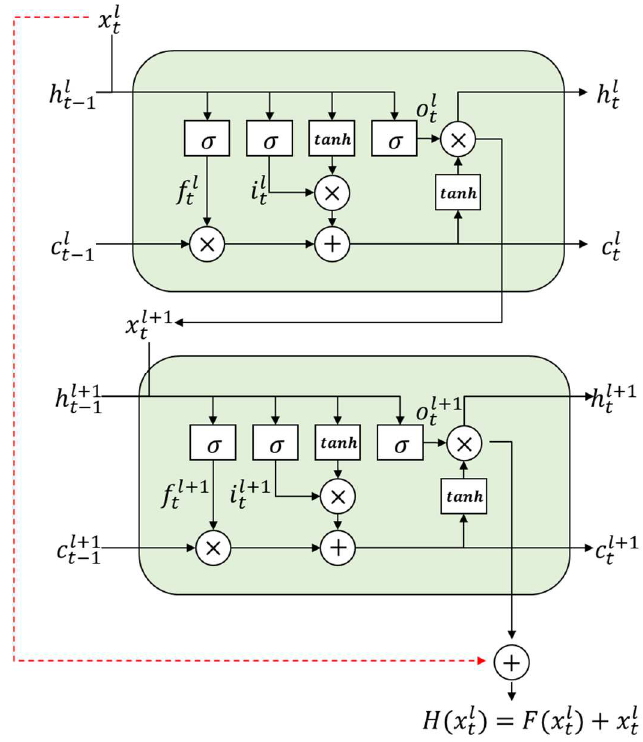
Figure 4. Structure of residual LSTM.